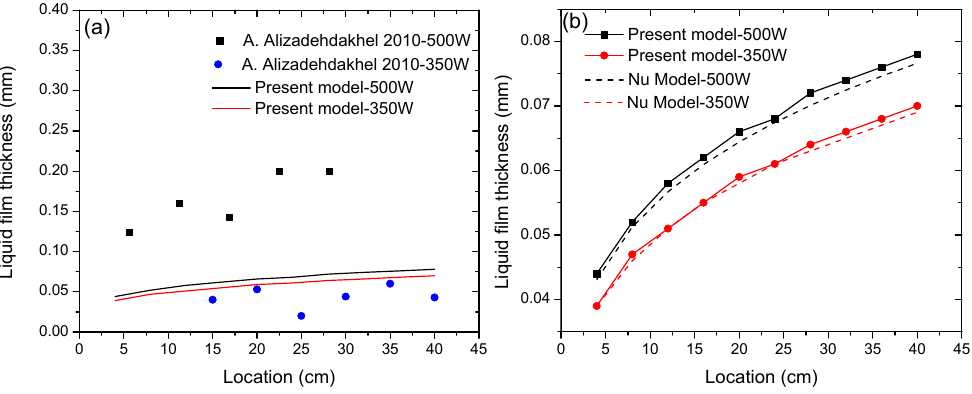
Figure 6. Validation of present liquid film model by comparing it with ( a ) CFD results by A. Alizadehdakhel et al. [51], and ( b ) Nusselt’s model. Alizadehdakhel et al. [51], and ( b ) Nusselt’s